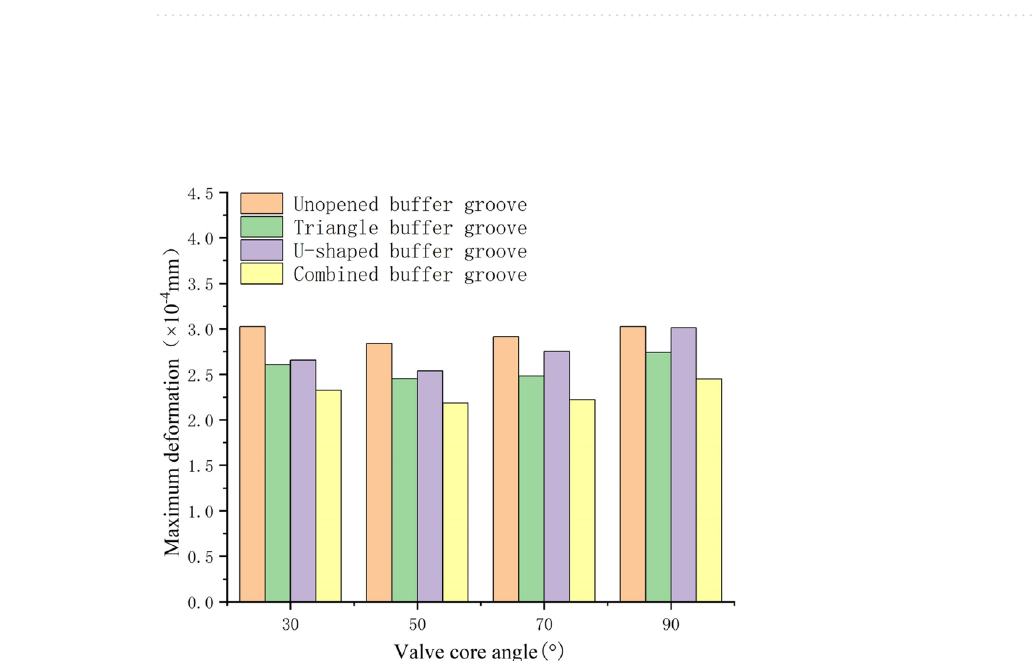
Figure 20. Deformation diagram of valve sleeve and valve core under combined buffer tank.